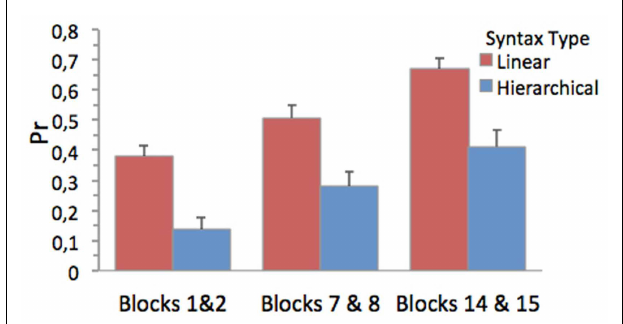
FIGURE 2 | Discriminability between correct and in correct sentences measured as Pr [p(hit)-p(false alarm)] and averaged for the initial (Blocks 1 and 2), the middle (Blocks 1 and 2), and the final two test blocks (Blocks 14 and 15) and the within-subject factor syntax type. Bars shows means errors bars indicate mean 1.0 standard errors (SE).